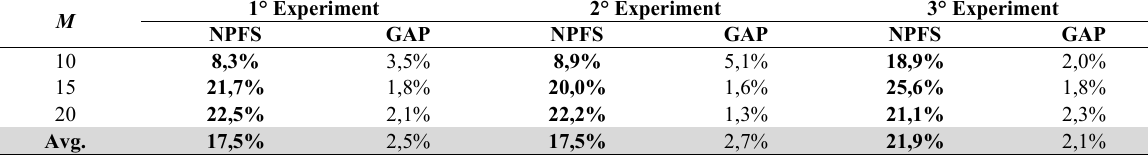
Summary of the results of the three experiments for M ϵ {10, 15, 20}. 1° Experiment 2° Experiment 3° M